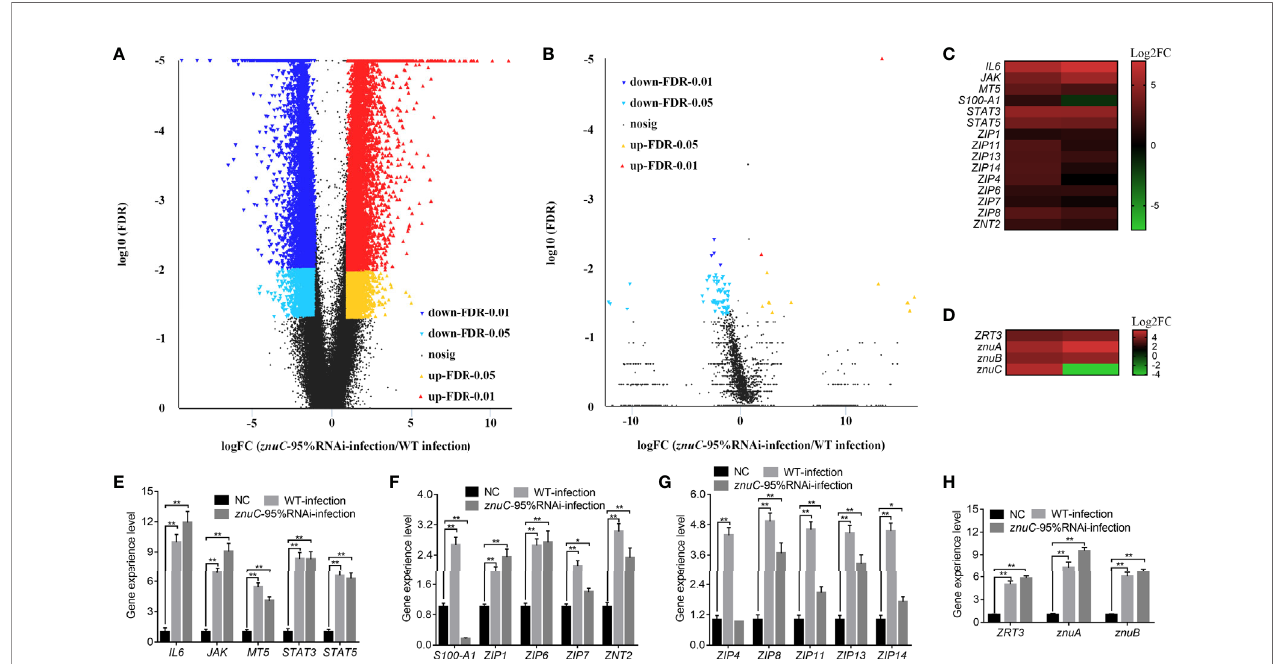
FIGURE 4 | Dual RNA-seq reveals differentially expressed genes (DEGs) associated with the trade-off for Zinc (Zn) between host and pathogen during Pseudomonas plecoglossicida infection. (A, B) Dual RNA-seq was carried out to assess spleen specimens from Epinephelus coioides upon infection with P. plecoglossicida for 48h. Compared to the wild-type P. plecoglossicida group, spleen specimens from animals infected with the znuC- 95%RNAi strain had 23,059 DEGs, including 12,005 downregulated and 11,054 upregulated genes. Totally 5,103 genes were detected in the transcriptome of P. plecoglossicida from E. coioides spleen. In comparison to wild-type P. plecoglossicida in E. coioides spleen, the znuC- 95%RNAi strain had 88 DEGs, including 74 downregulated and 14 upregulated genes. Volcano plot indicated upregulated and downregulated genes of E. coioides (A) and P. plecoglossicida (B) detected by dual RNA-seq here. (C, D) Among all the DEGs, 15 Zn nutritional immunity related genes were identi fi ed in E. coioides , while 4 DEGs related to Zn acquisition were found in P. plecoglossicida . Heat maps indicated E. coioides Zn nutritional immunity related genes and P. plecoglossicida Zn acquisition genes (adjusted FDR < 0.05; | log2FC | ≥ 1; n=3) compared to healthy E. coioides . Upregulated and downregulated genes are colored in red and green, respectively. (E, F) quantitative real time PCR (qRT- PCR) analysis of E. coioides Zn nutritional immunity related genes and P. plecoglossicida Zn acquisition genes in E. coioides injected with PBS, wild type and znuC - RNAi P. plecoglossicida , respectively. Values are mean ± SD (n = 3, * P < 0.05, ** P <